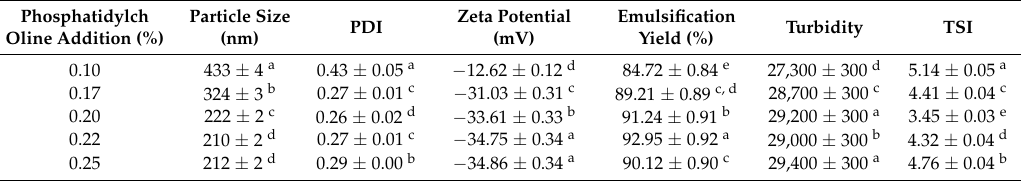
Phosphatidylch Oline Addition